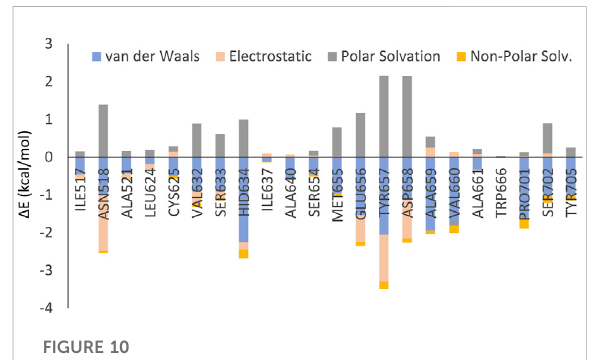
FIGURE 10 Results of the per-residue decomposition analysis obtained from the MD simulation of the 11q-RdRp